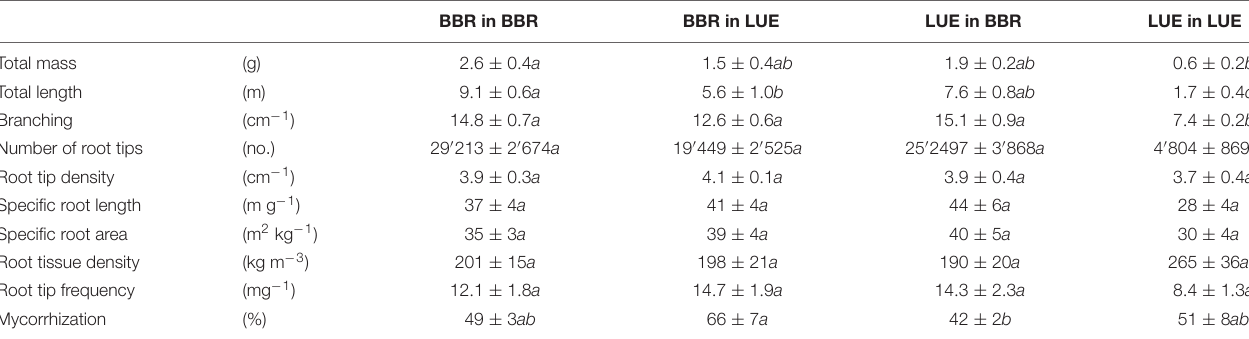
TABLE 3 | Morphological traits of fine roots ( < 2 mm diameter), as measured during the second growing season in a rhizobox experiment with beech ( Fagus sylvatica L.) saplings originating from the sites Bad Brückenau (BBR) and Unterlüss (LUE), respectively.